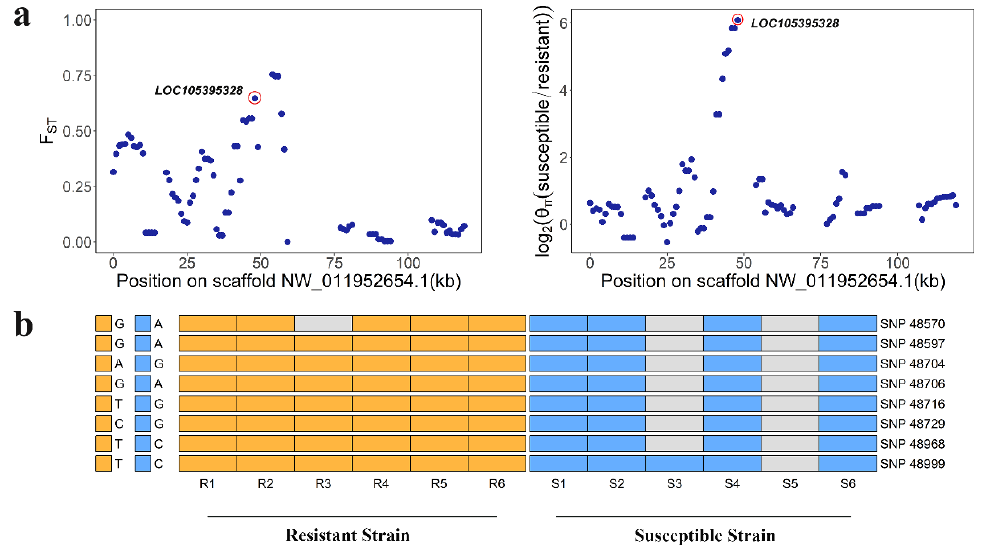
Figure 4. CYP6B6-like ( LOC105395328 ) shows different genetic signatures between resistant-strain and susceptible-strain Plutella xylostella . ( a ) F ST and log 2 ( θ π (susceptible/resistant)) plot around the CYP6B6-like locus. The F ST and log 2 ( θ π (susceptible/resistant)) value of CYP6B6-like is almost highest for scaffold NW_011952654.1, circled in red. ( b ) The eight SNPs were identified in resistant strains of Plutella xylostella and absent in susceptible strains of Plutella xylostella . SNPs were named according to their position on the scaffold. The gray cell represents data missing.